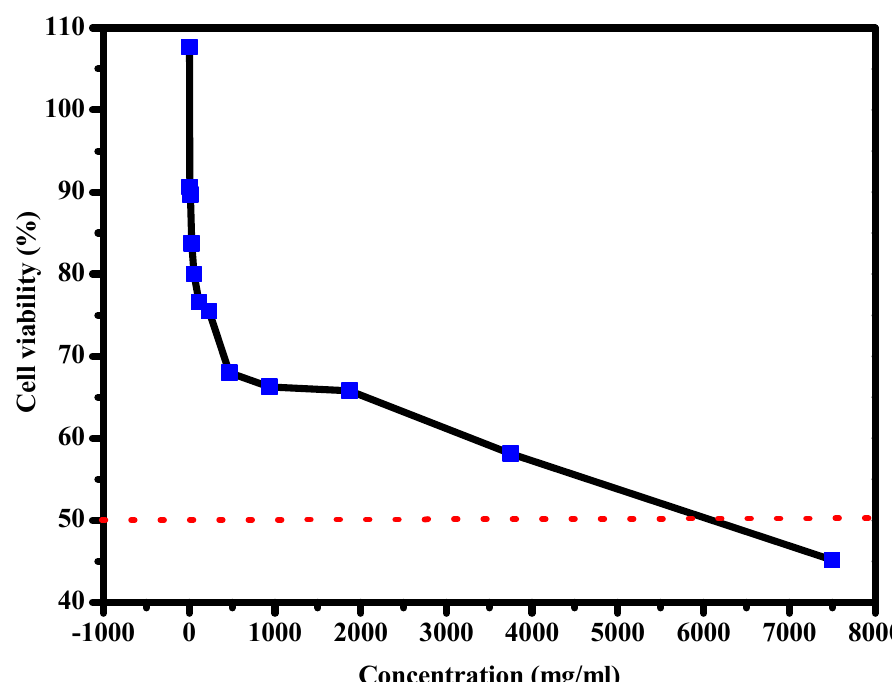
Figure 8. Cell viability graph of CA cast film with different contributions of nanoparticles after culture with normal lung cells (D).